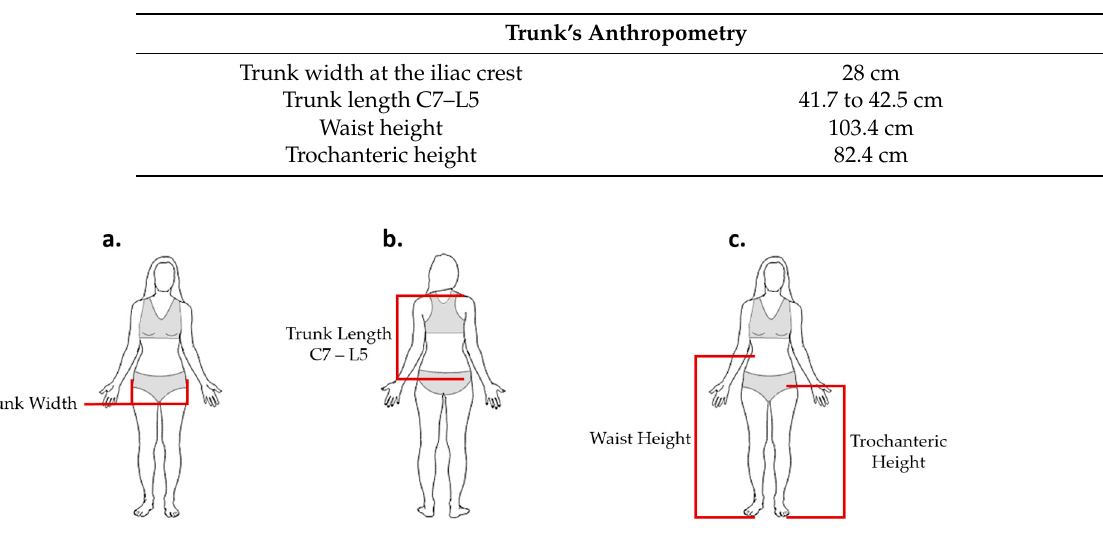
Figure 8. Anthropometric dimensions. ( a ) Trunk width at the iliac wrest [32], ( b ) trunk length from C7 to L5 [31], ( c ) waist height and trochanteric height [30]. Adapted from [34].